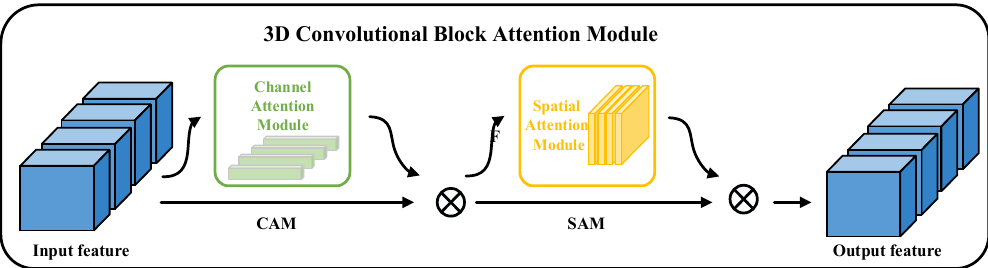
Figure 3. 3D convolutional block attention module.